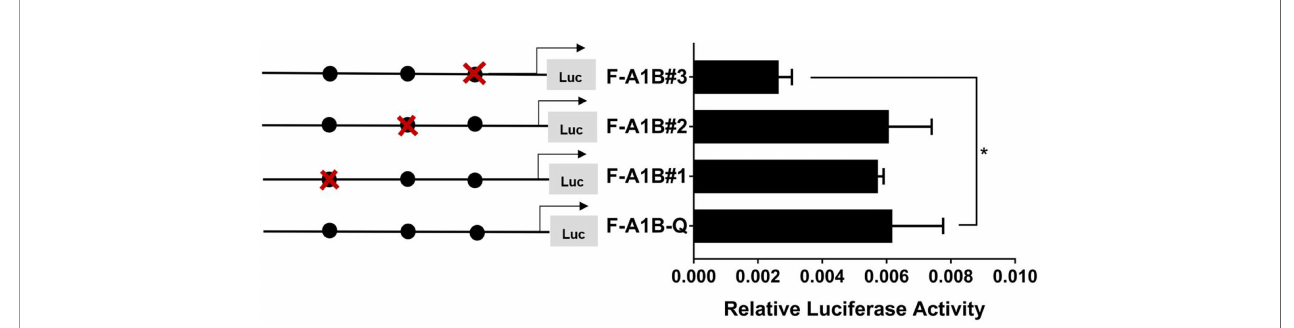
FIGURE 13 | Effect of FOXL2 on transcriptional activity of the cyp19a1b promoter fragment mutated at the transcriptional site. On the left is a schematic diagram of the mutation of the promoter site, and the circle represents the binding site. The right side is the expression of luciferase in the promoter recombinant vector. The black circle with a red cross represents the FOXL2 mutation site. One-way ANOVA was performed on the data and expressed as mean ± standard deviation (n = 4). *There is a signi fi cant difference between the